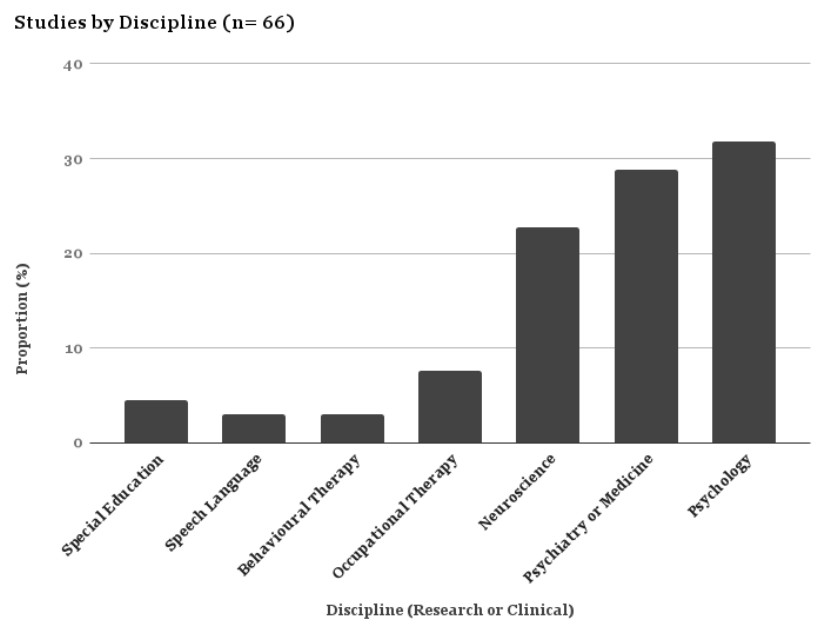
Figure 3. Proportional Table–Studies by Discipline.